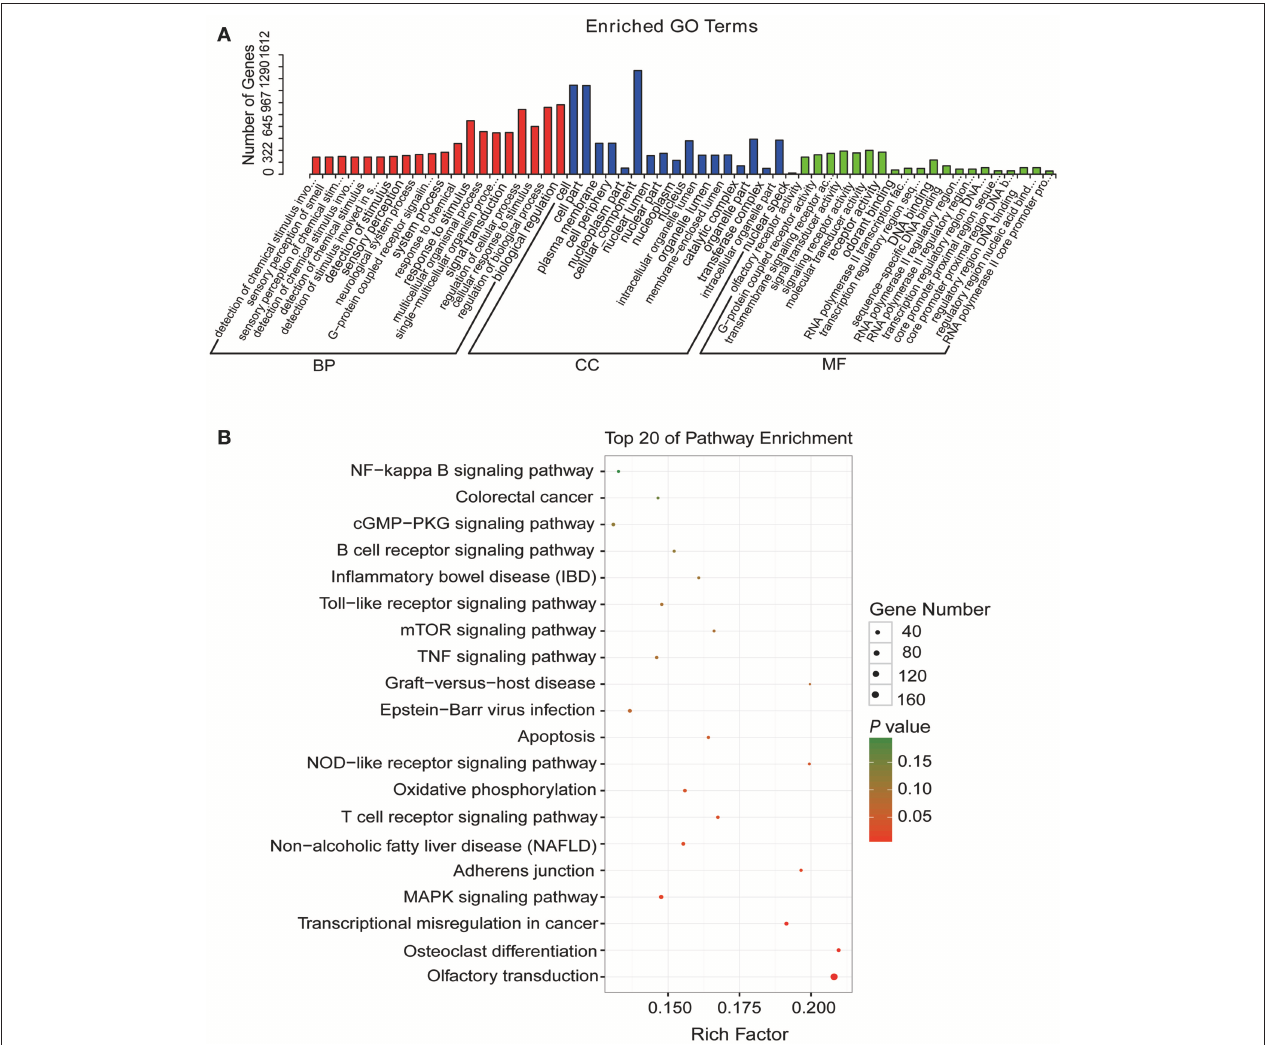
FIGURE 6 | The functional enrichment analyses of target genes of the disease-related lncRNAs. (A) Gene ontology (GO) function annotation of target genes of the disease-related lncRNAs. The X-axis indicates the gene numbers and the Y-axis indicates the detailed terms. (B) Kyoto encyclopedia of genes and genomes (KEGG) pathways of target genes of the disease-related lncRNAs. The X-axis indicates the gene ratio and the Y-axis indicates the name of KEGG pathway. The size of dots indicates the numbers of target genes, and the color of dots indicates P -value (Fisher’s Exact